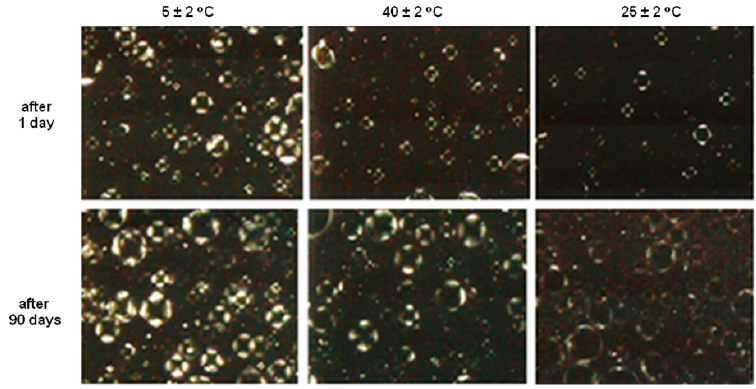
Figure 5. Polarized light photomicrograph (200×) of formula 7.0 after 24 h and 90 days under various storage conditions.